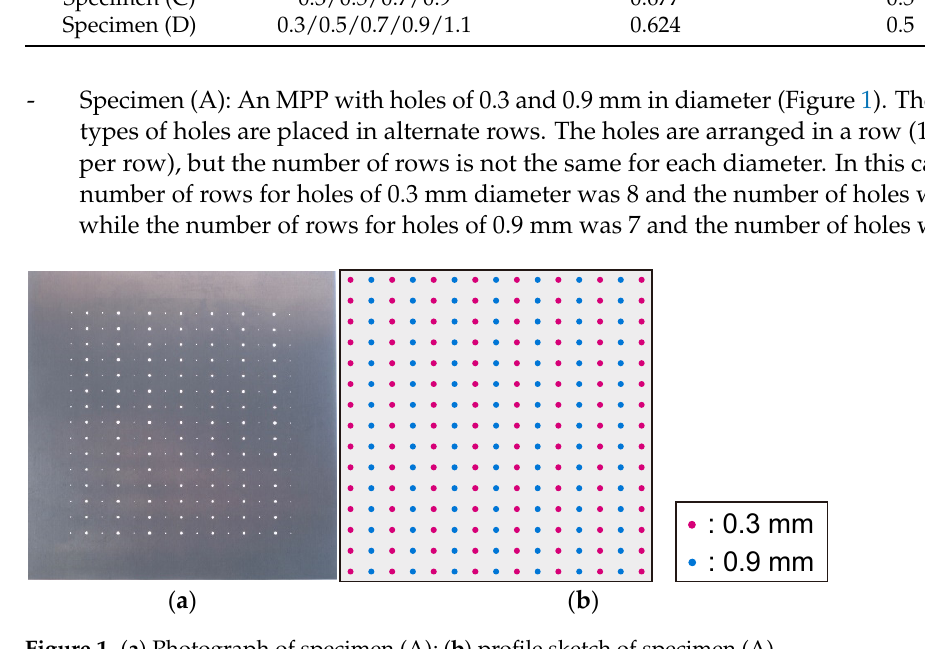
Figure 1. ( a ) Photograph of specimen (A); ( b ) profile sketch of specimen (A).